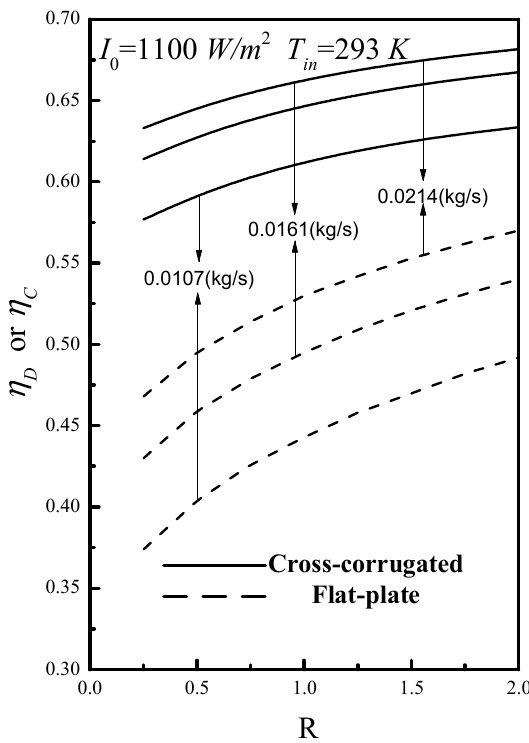
Figure 7. Comparisons of collector efficiencies for both recycling flat-plate and cross-corrugated solar air collectors ( I 0 = 1100 W/m 2 ).